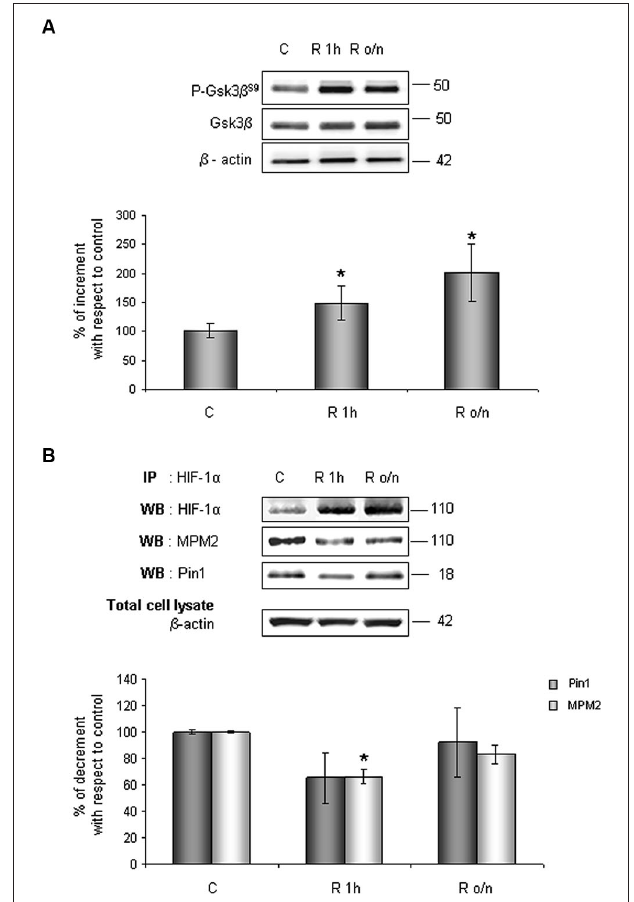
FIGURE 6 | In post-OGD conditions P-Gsk-3 β S9 levels increases . Cells were subjected to OGD treatment and restoration of normoxic and glucidic conditions for different times (R 1 h, R o/n). (A) Cells were collected and lysed with 2% SDS lysis buffer. Equal amounts of samples (as protein content) were subjected to SDS-PAGE and western blot analysis. Gsk-3 β and P-Gsk-3 β S9 levels were detected by specific antibodies, revealed by ECL and semi-quantitatively determined by a KODAK image station 2000R. Anti- β -actin antibody was employed to confirm equal protein loading in the different lanes. Results obtained are shown on the bar-graphs. The amount of P-Gsk-3 β S9 correspond to phospho-protein level on Gsk-3 β total protein. Normalization was carried out with respect to the β -actin amount in the same sample. (B) HIF-1 α phosphorylation on Ser/Thr-Pro motifs and HIF-1 α /Pin1 interaction was evaluated after HIF-1 α immunoprecipitation using western blot analysis. Cells were collected and lysed in non denaturising NP40 buffer. Western blot analysis performed on immunoprecipitated proteins showed bands corresponding to Pin1 protein (18 kDa), HIF-1 α protein and HIF-1 α phosphorylated on Ser/Thr-Pro motifs (110 kDa). Proteins were detected by specific antibodies (anti-HIF-1 α ; anti-MPM2; anti-Pin1), revealed by ECL and semi-quantitatively determined by a KODAK image station 2000R and the results obtained are shown on the bar-graphs. IP, immunoprecipitation; WB, western blot. Data represent the mean ± SEM of three separate experiments performed in triplicate. Statistical significance is obtained with Student’s t -test in comparison with controls. * p < 0.05, ** p < 0.01.